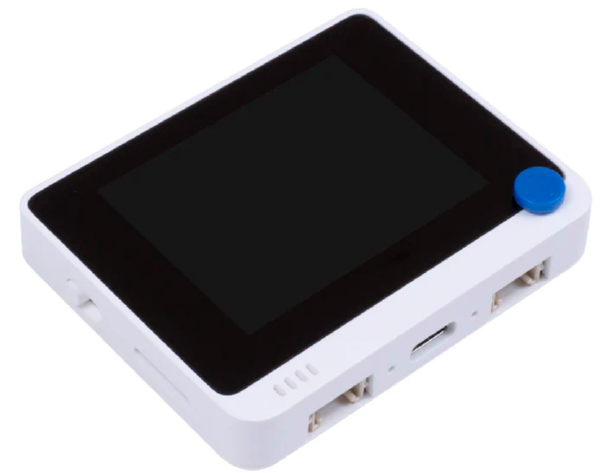
Figure 5. Wio terminal as the second RTU. Table 4. Specification of the Wio terminal [29].